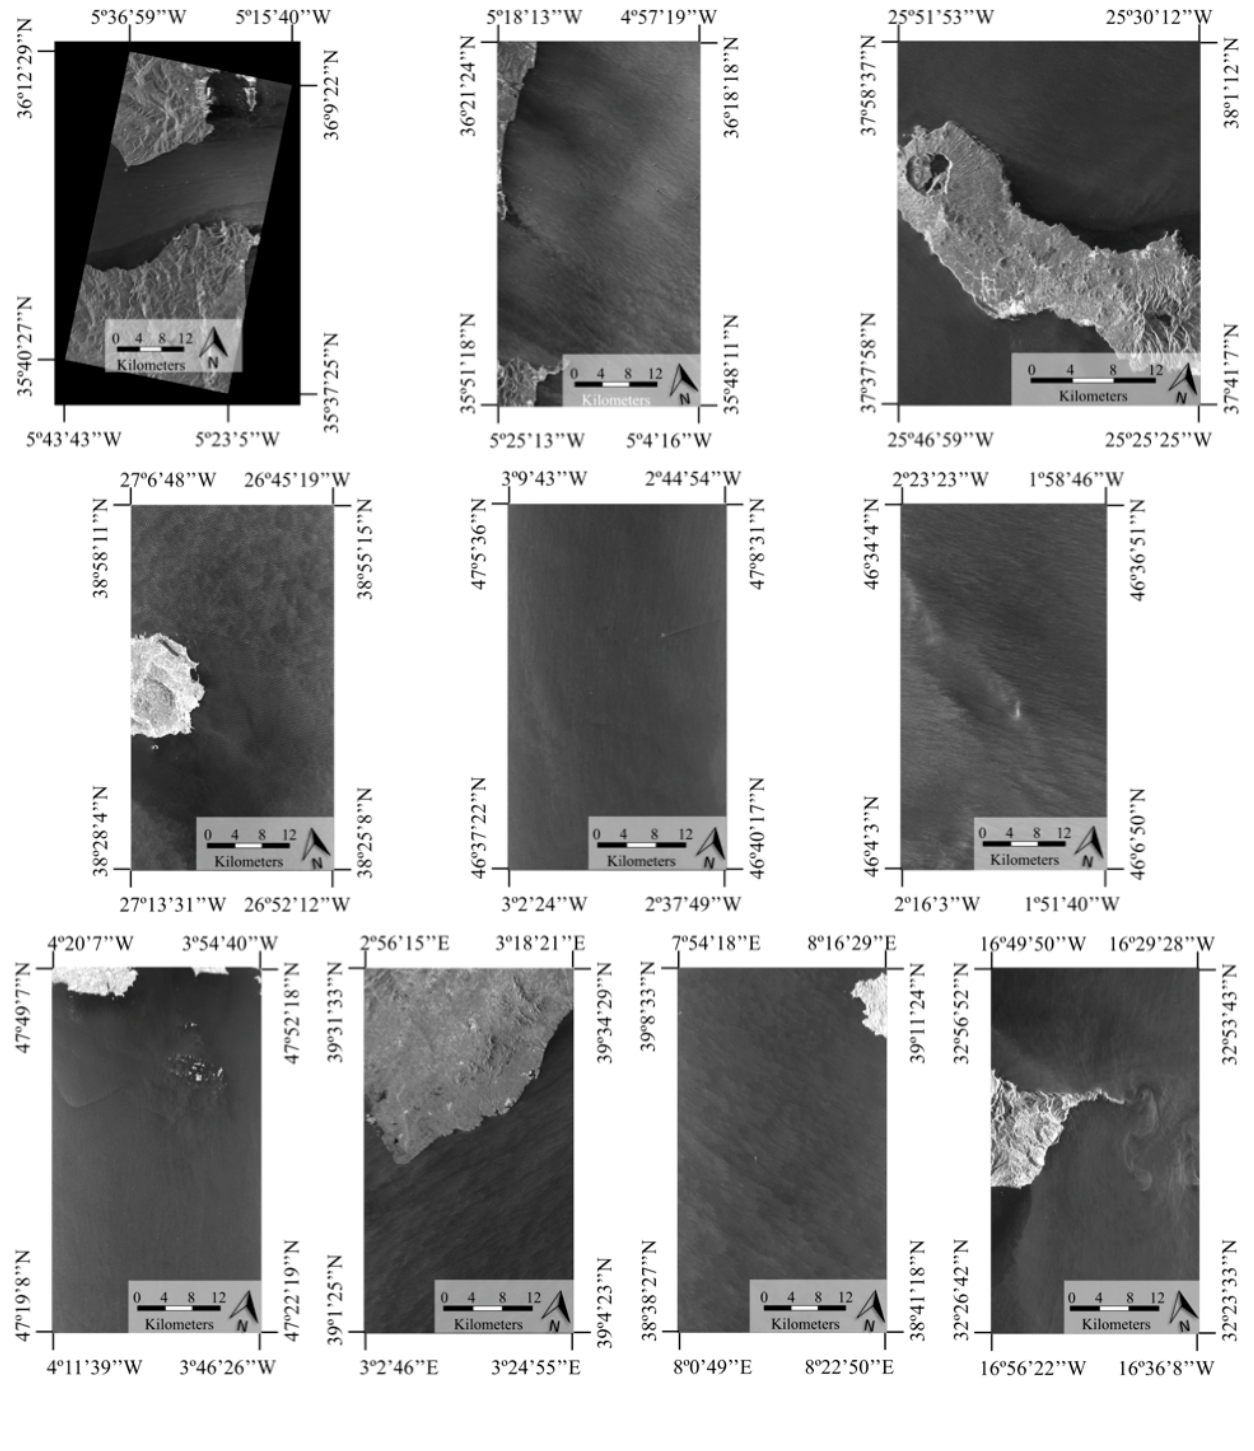
Figure 2. Quick looks of the TerraSAR-X